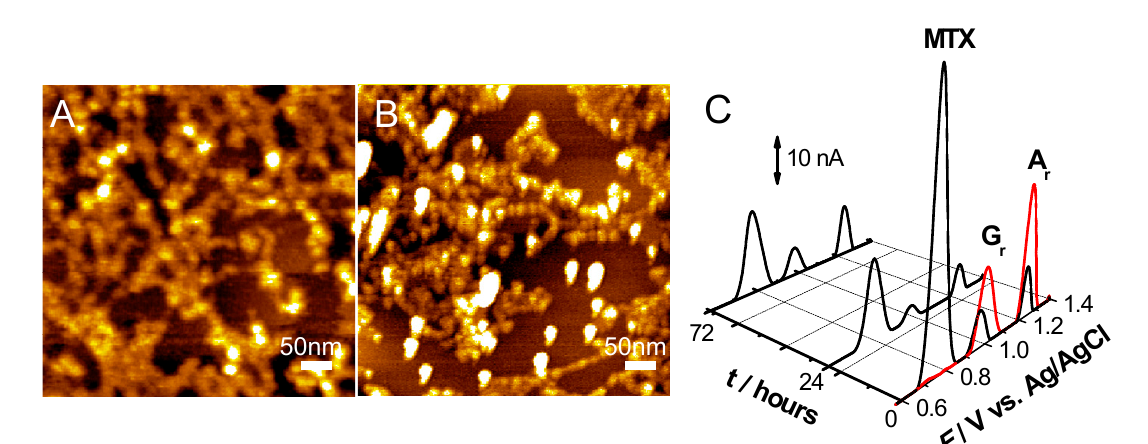
Figure 6. ( A , B ) AFM images at HOPG of ( A ) 10 µg mL –1 dsDNA and ( B ) 10 µg mL –1 dsDNA incubated with 0.5 µM methotrexate (MTX), for 24 h. ( C ) Baseline-corrected DPV at a GCE, at pH 4.5, of (red line) 100 µg mL –1 dsDNA and (black line) 100 µg mL –1 dsDNA incubated with 5 µM MTX, during different time periods. Adapted from [90] with permission.